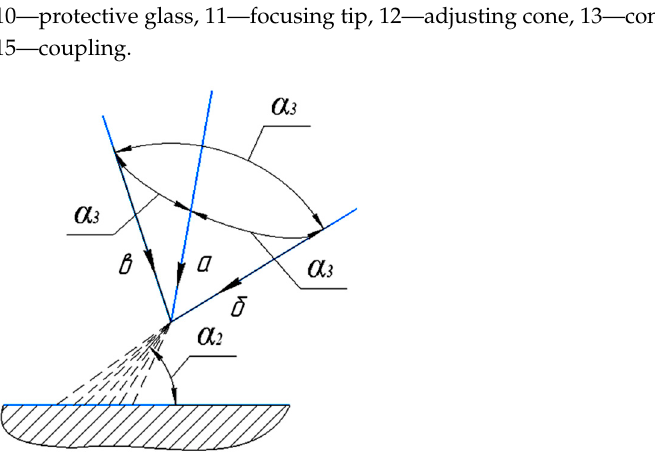
Figure 11. The scheme of vectors forming a regular pyramid when sprayed with a laser.